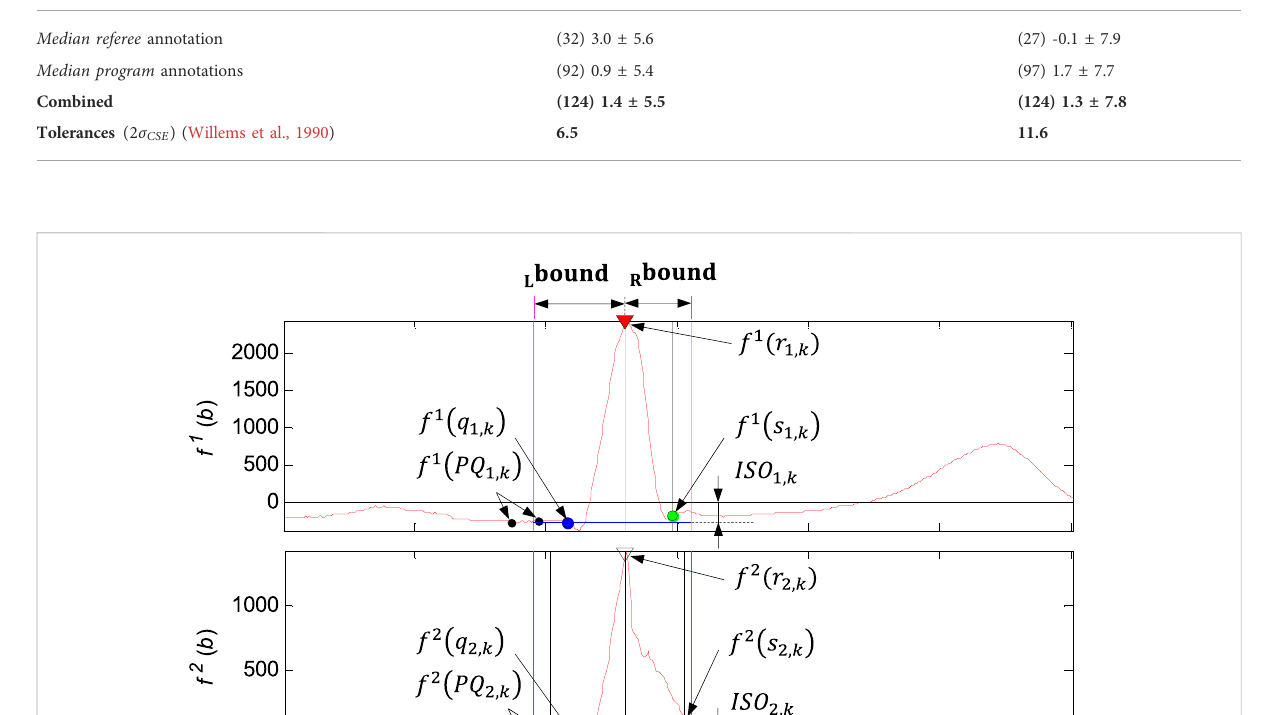
r r q i , k of 3 , k (empty triangle), function values in the points 2 , k ,